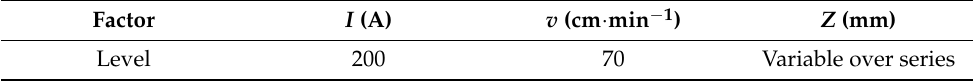
Table 5. Standard levels of observed factors.